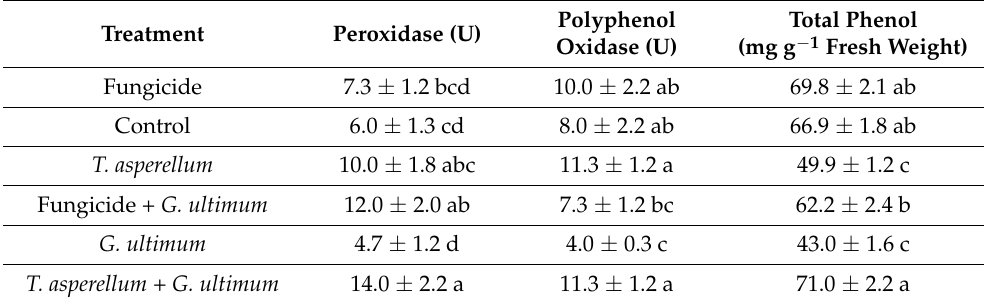
Table 4. Defense-related enzymes and total phenols of pea plants under inoculation with T. asperellum ZNW and/or G. ultimum NZW.